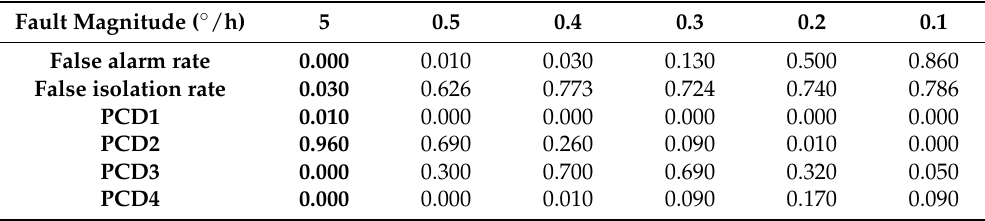
Table 4. Calculation results of Monte Carlo simulations.